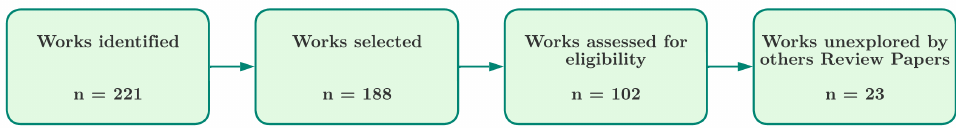
Figure 6. Diagrams of the selection process and the number of works found based on previous review